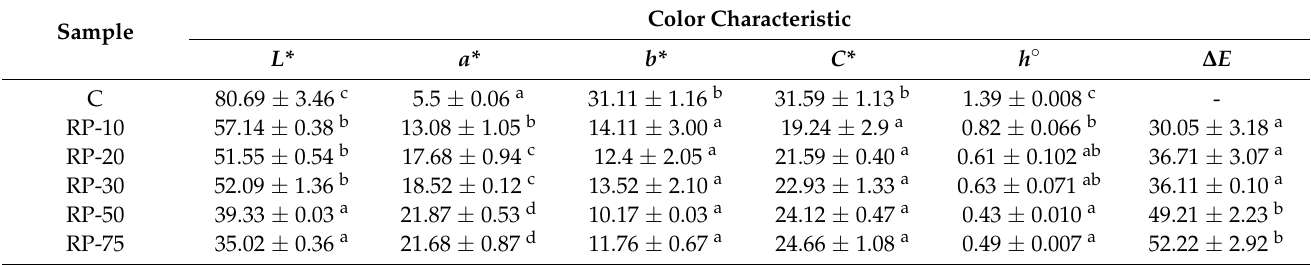
Table 3. Assessment of wafer color